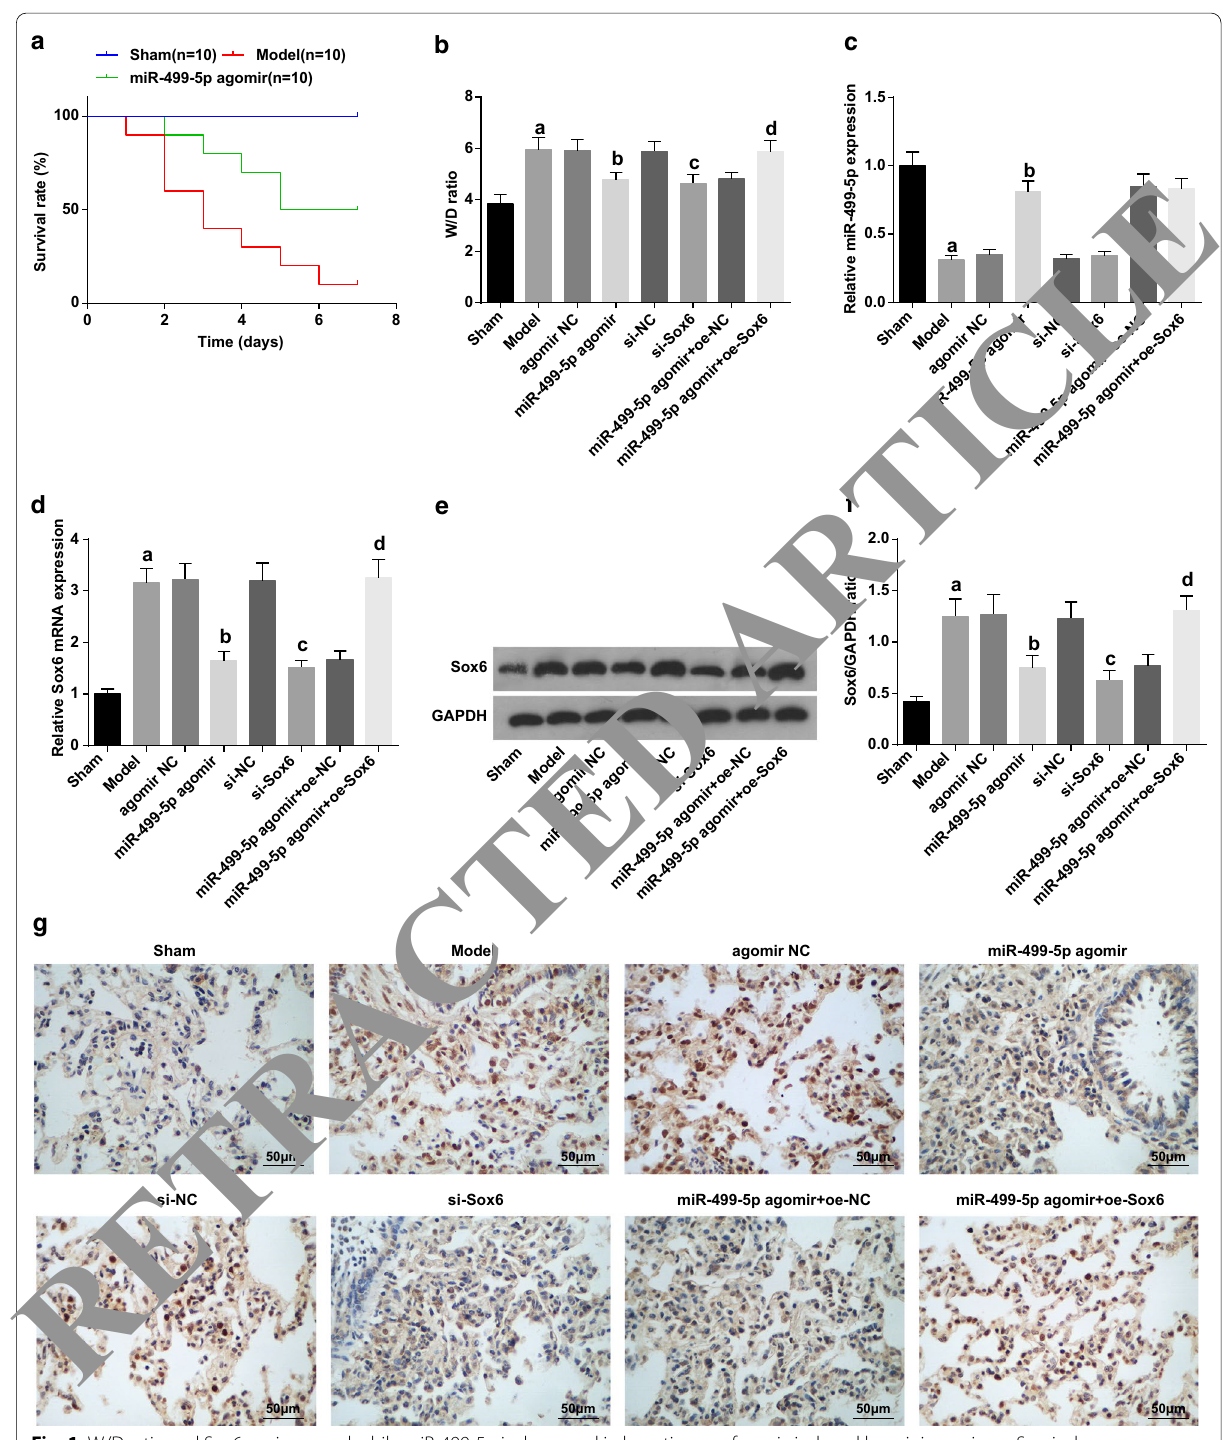
Fig. 1 W/D ratio and Sox6 are increased while miR-499-5p is decreased in lung tissues of sepsis-induced lung injury mice. a Survival curve of mice made by Kaplan–Meier. b W/D ratio of lung tissue in each group. c Expression of miR-499-5p in lung tissues of mice. d Expression of Sox6 mRNA in lung tissues of mice. e Protein band of Sox6 by western blot analysis. f Protein expression of Sox6 in lung tissues of mice. g Sox6 immunohistochemistry of lung tissues of mice. (a) P < 0.05 versus the sham group. (b) P < 0.05 versus the agomir NC group. (c) P < 0.05 versus the si-NC group. (d) P < 0.05 versus the miR-499-5p agomir oe-NC group. Measurement data were depicted as mean standard deviation, and data + ± were assessed by one-way ANOVA followed by Tukey’s post hoc